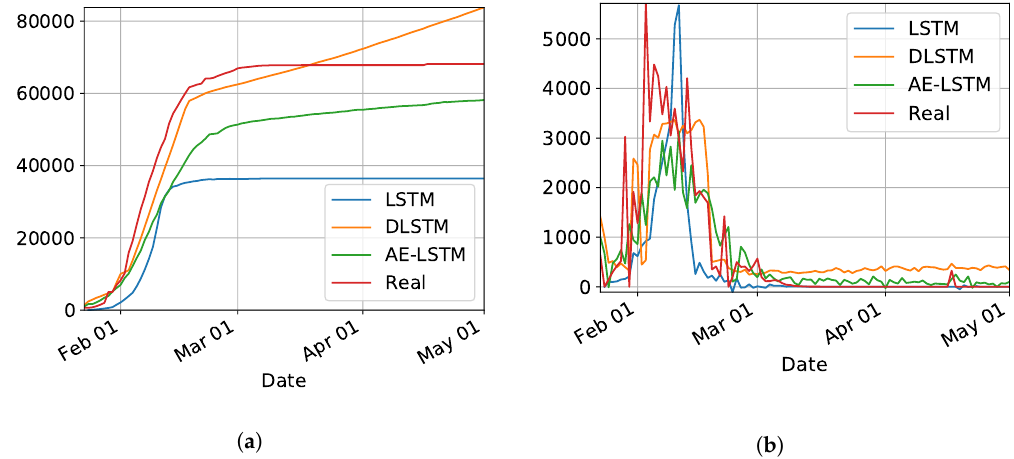
Figure 2. Comparison results for LSTM, DLSTM, and LSTM-SAE on Covid-19 cumulative ( a ) and daily ( b ) number of cases, data from Hubei, province of